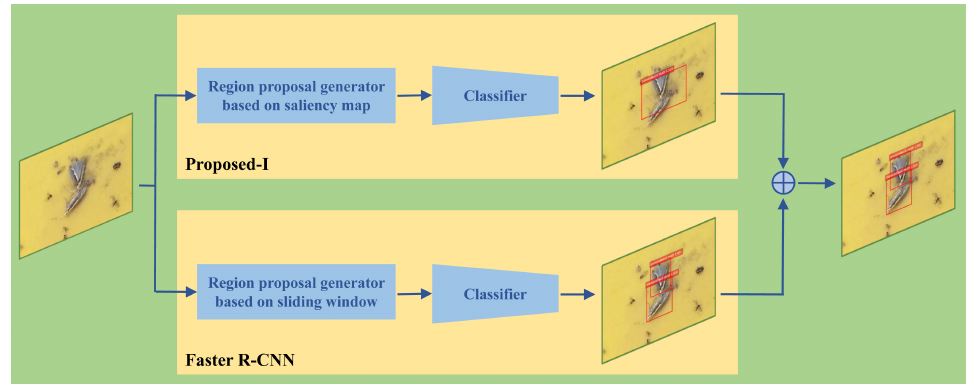
Figure 5. The architecture of the enhanced insect pest counter using the dual-path network. The top path is the proposed network described in Section 3 and the bottom path is Faster R-CNN. ‘ ⊕ ’ denotes the fusion